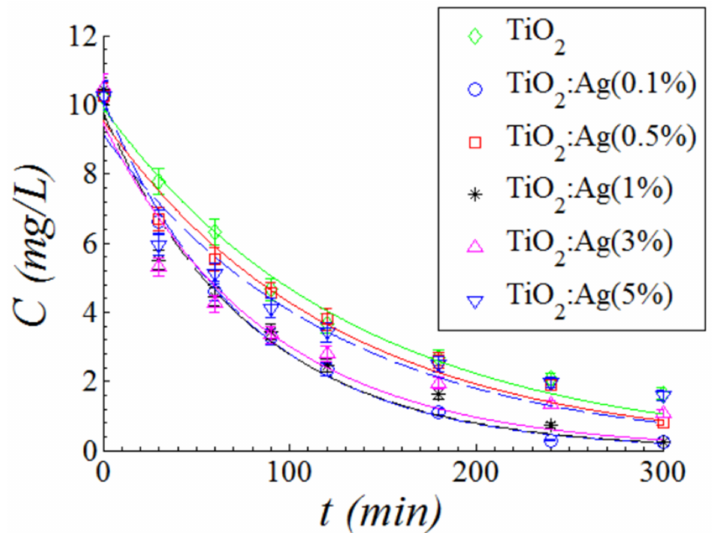
Figure 9. Kinetics plots of MB dye decay against irradiation time during the photodegradation process under halogen lamp in the presence of Ag–TiO 2 nanostructured nanofibers catalysts. Solid and dash lines represent predictions given by PFO kinetic model. Experimental conditions: catalyst